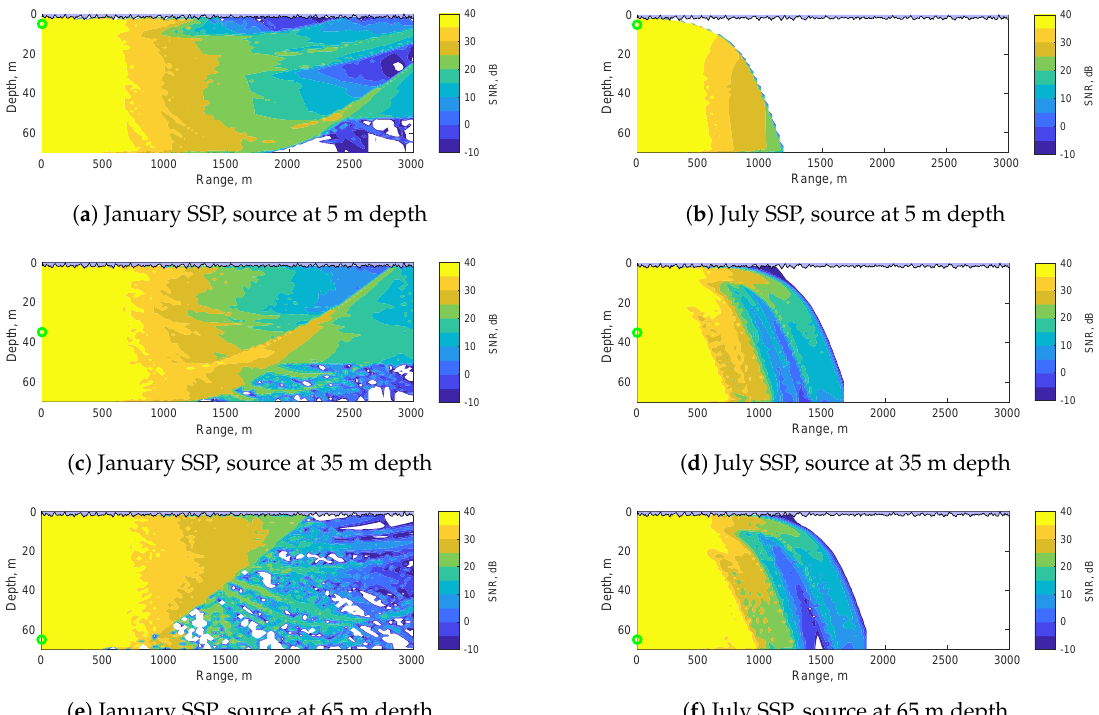
Figure 4. Signal-to-Noise Ratio (SNR) computed using beam tracing simulations of the North Sea environment. The communication coverage and channel quality are significantly affected by the refraction of acoustic waves and the node positions in the water column. Signal